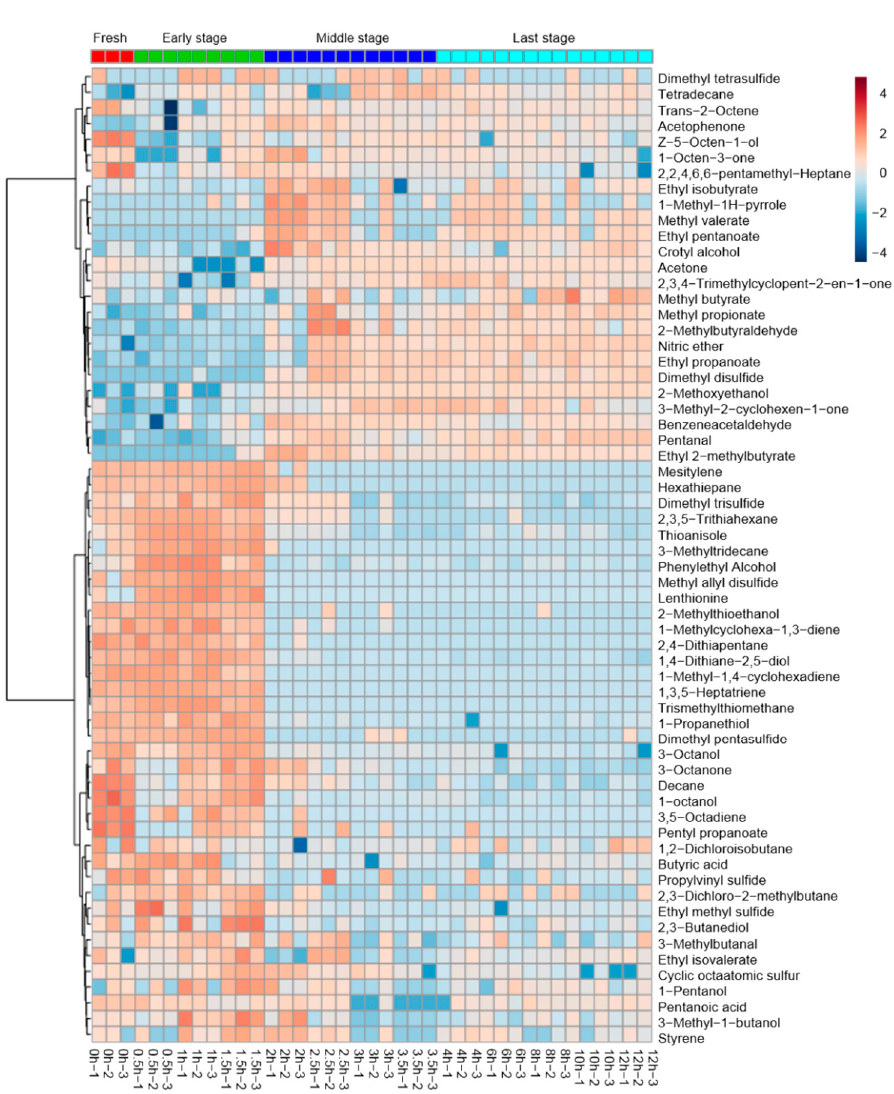
Figure 4. Clustering Heatmap of the concentration of volatile compounds in L. edodes at different drying times.